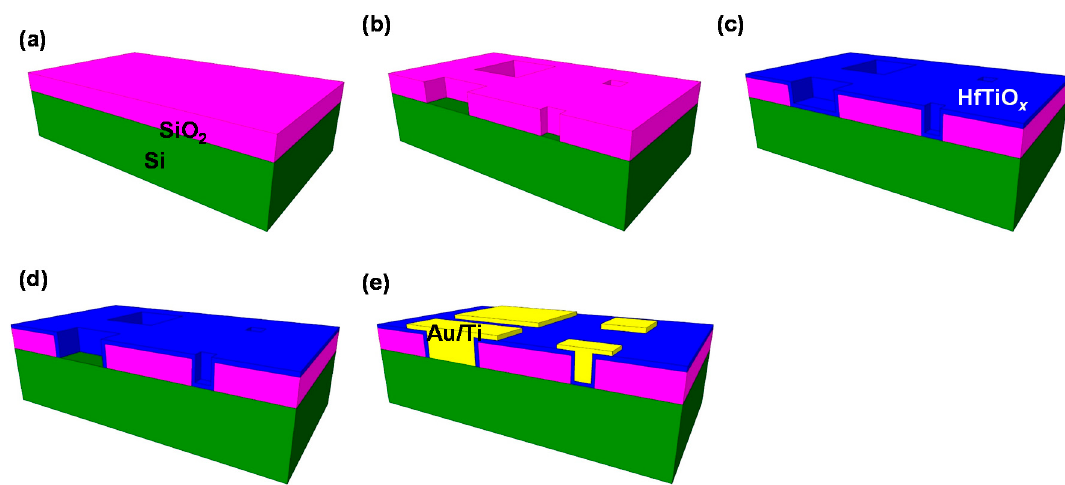
Figure 1. Fabrication process of Au/Ti/HfTiO x /p-Si device in contact hole structure: ( a ) SiO 2 deposition as mold layer; ( b ) etching process after patterning; ( c ) HfTiO x layer deposition; ( d ) etching process of bottom electrode; ( e ) Au/Ti deposition into contact hole.